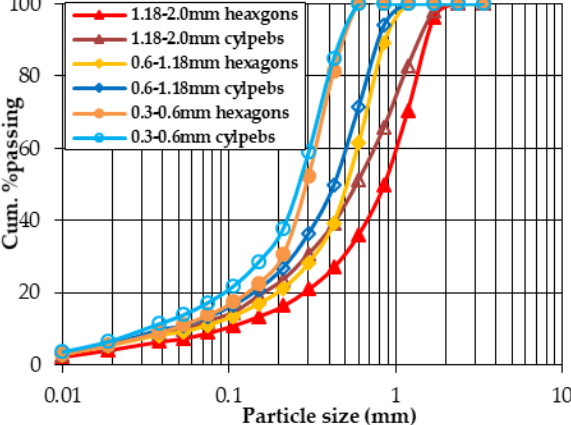
Figure 5. Size distributions of ground product with three single-sized feeds and a 2-min grinding duration.